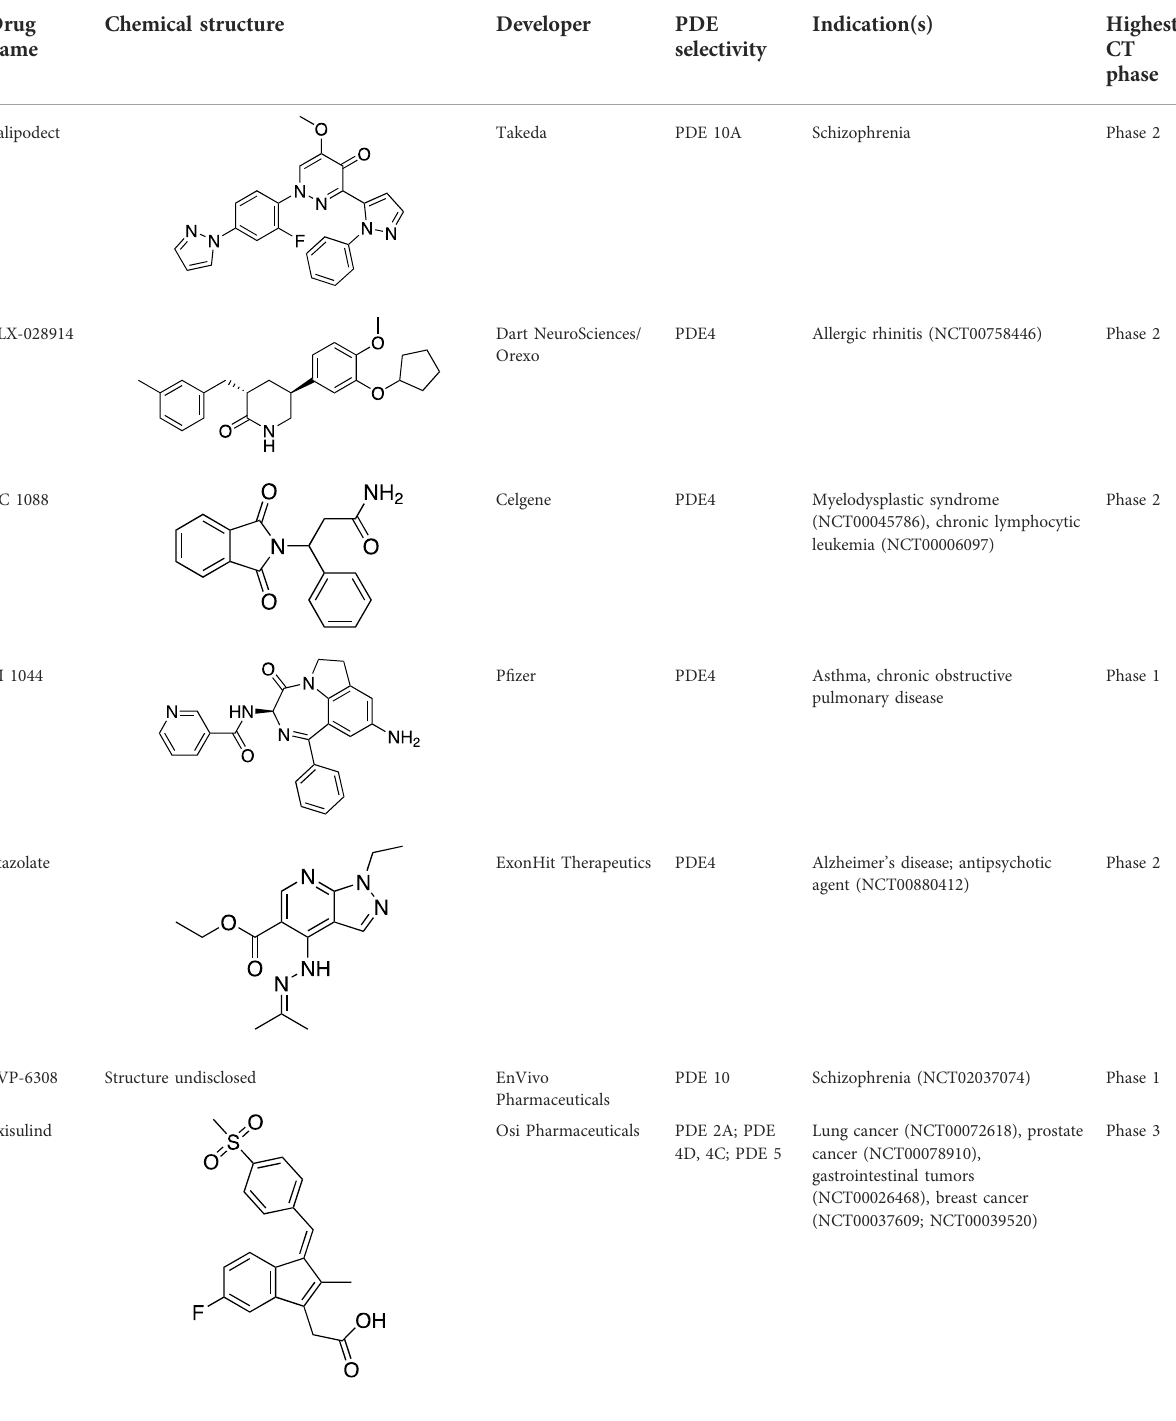
TABLE 6 Investigational PDE inhibitors in discontinued or unknown clinical development. This table provides a summary on the investigational PDE inhibitorsthathavebeenevaluatedclinically,butwhosedevelopmentiseitherdiscontinuedasof2022orisotherwiseunknown.Theaggregated data on clinical trials is listed as per the ClinicalTrials.gov, the EU Clinical Trials register and PubMed databases and/or the developers ’ websites. Chemical structures are derived from the PubChem database (Kim et al., 2021). Developer names are listed according to the relevant studies. Development status is listed according to the AdisInsight database